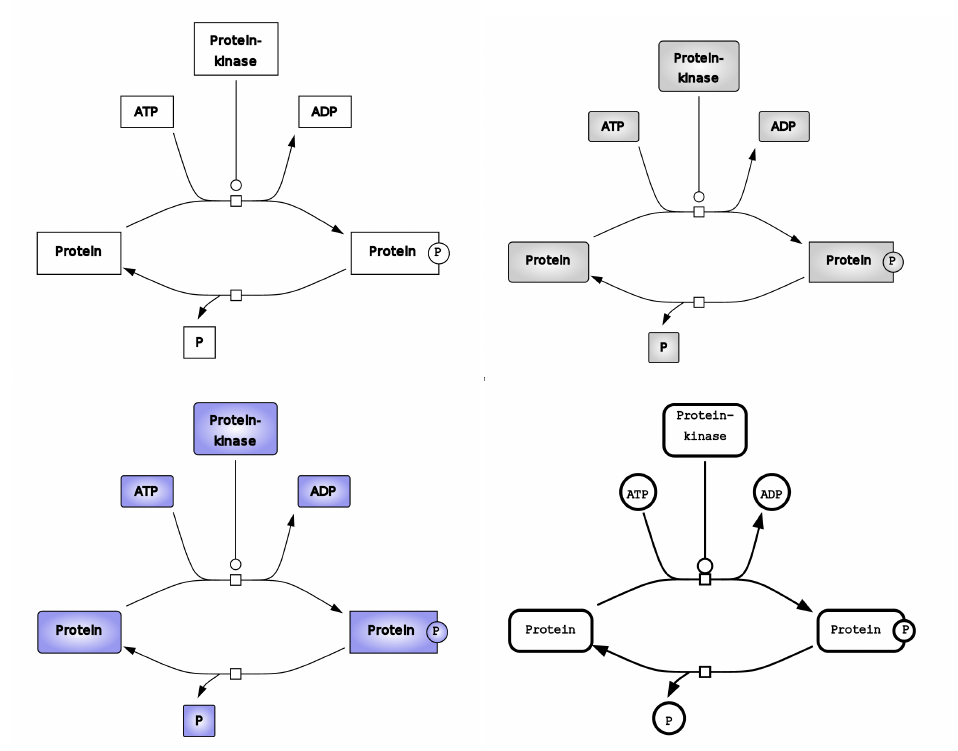
Figure 16: example converted to SVG and rendered with Google Chrome